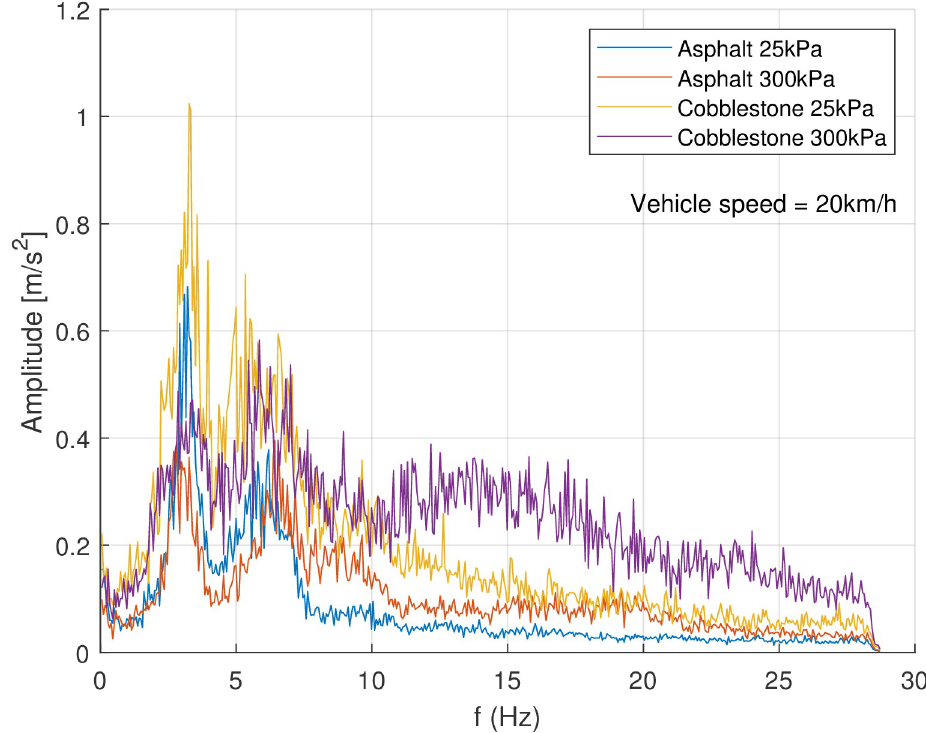
Fig 9. Single sided amplitude spectrum of the vertical acceleration a trailer on asphalt and cobblestones. For each setting about ten test runs were combined by means of arithmetic amplitude mean